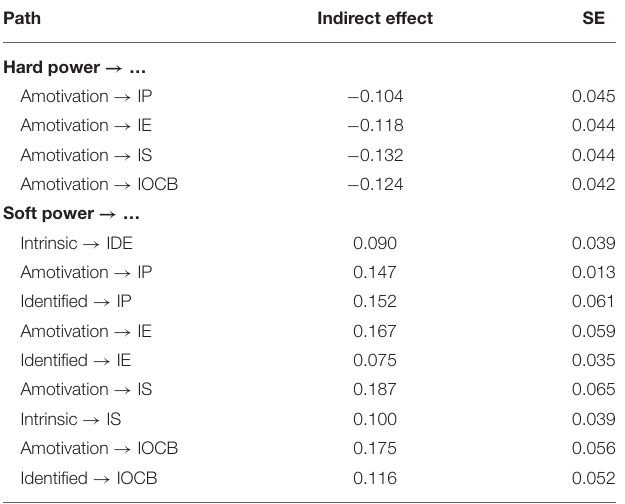
TABLE 3 | Summary of significant, specific indirect effects for Model 4 in Study 1.